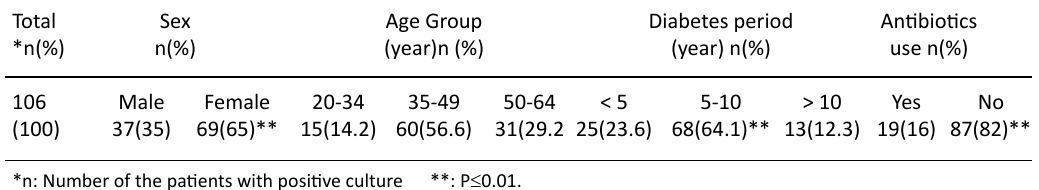
Table 3. Prevalence of UTIs in diabetic patients according to some factors Total Sex Age